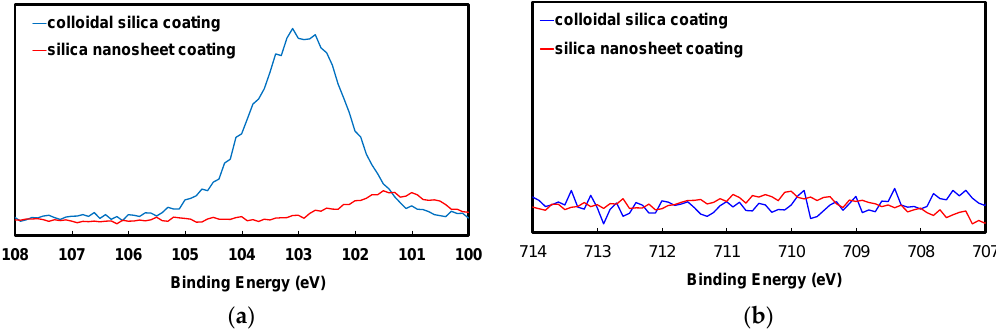
Figure 8. XPS ( a ) Si2p; and ( b ) Fe2p3/2 core level spectra of iron powder particles coated five times with colloidal silica or silica nanosheets over Sr-B-P-O insulating